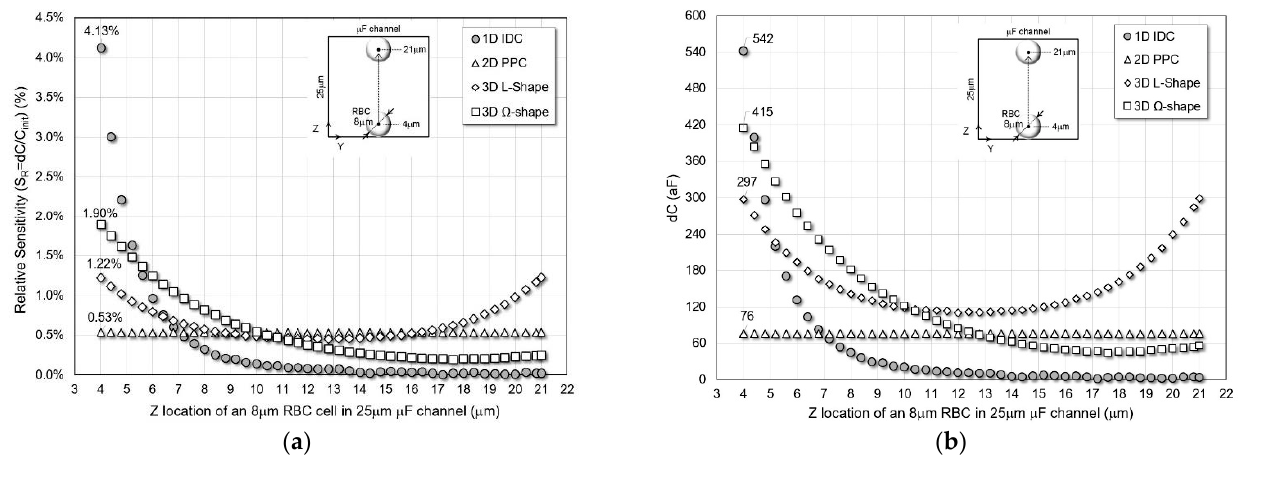
Figure 5. ( a ) Relative sensitivity and ( b ) capacitance change of the sensors for varying Z location of 8 μ m RBC cell in 25 μ m microfluidic channel. 8 µ m RBC cell in 25 µ m microfluidic